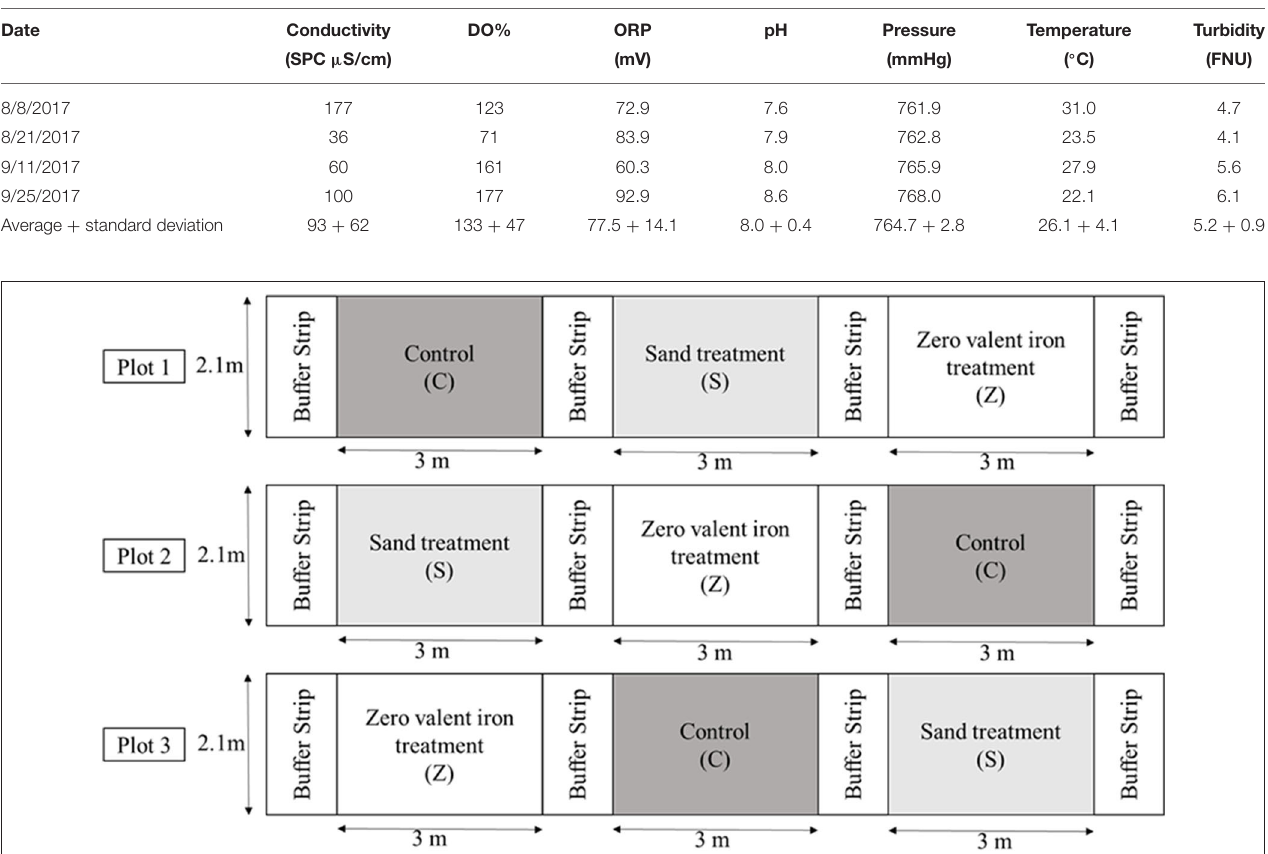
TABLE 1 | Pond water quality characterization for dates during laboratory ZVI-sand or sand filtration trials to reduce inoculated E. coli levels.